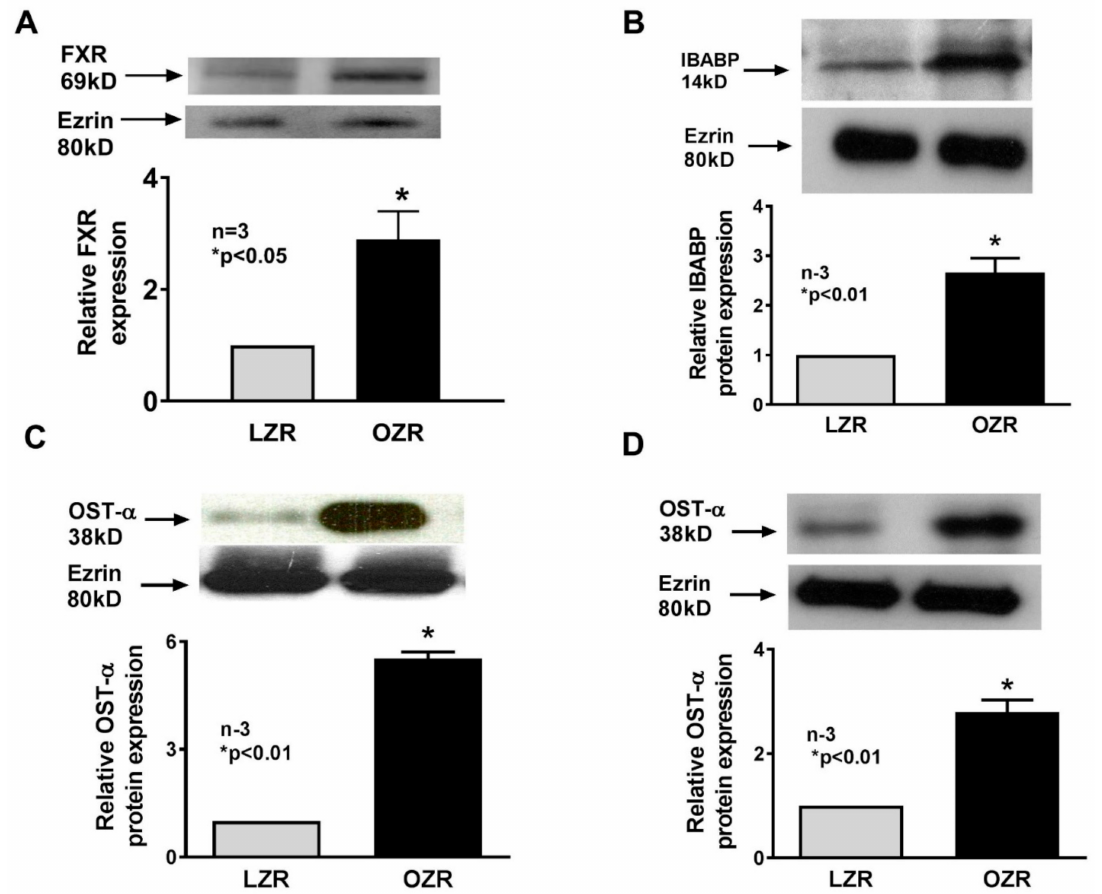
Figure 6. FXR and bile acid handling protein expression in Zucker rat villus cells. ( A ) FXR expression was significantly increased in ileal villus cells from OZR compared to LZR. ( B ). Ileal bile acid binding protein levels were also significantly increased in villus cells from OZR compared to leans. ( C ) Organic solute transporter alpha (OST α ) protein expression was significantly increased in villus cells from OZR compared to LZR. ( D ) OST α protein expression was also increased in villus cell plasma membrane from OZR compared to